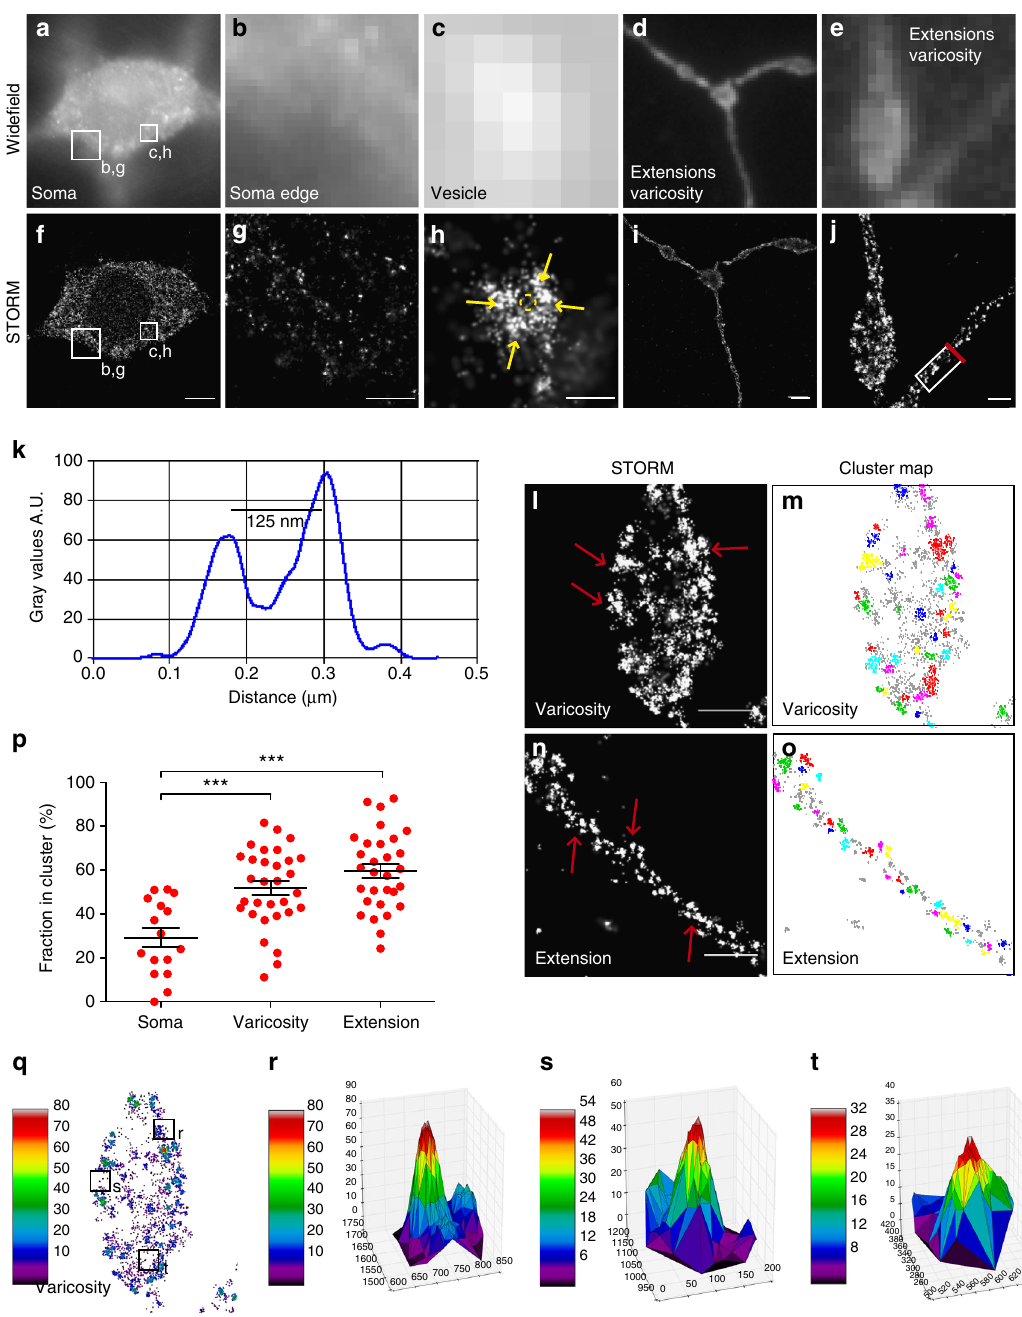
Fig. 3 Endogenous DAT is clustered in nanodomains in the extensions and varicosities of cultured dopaminergic neurons. a – c , f – h Cross-section views through dopaminergic cell body showing the DAT distribution in the soma in an overall view, the soma edge, and in intracellular vesicular structures. DAT was visualized by immunolabeling with primary DAT antibody and Alexa405-Alexa647-conjugated secondary antibody. a , f Wide fi eld image and corresponding reconstructed STORM image in the cell body. b , g Wide fi eld image and corresponding STORM image at the soma edge; c , h Enlarged wide fi eld or STORM image corresponding to the boxed regions in a , f , visualizing DAT in a putative endocytic vesicle. Yellow arrows highlight the circular distribution of the DAT signal. d , i Wide fi eld image and reconstructed STORM image in a representative extension with varicosities. e , j Enlarged wide fi eld image and corresponding STORM image of extension and varicosity. k Cross sectional pro fi le along the boxed region in j showing the signal intensity as a function of the distance ( µ m). l , m STORM image and corresponding DBSCAN-based cluster map showing the degree of clustering of DAT in a representative varicosity. n , o STORM image and corresponding DBSCAN-based cluster map showing the degree of clustering of DAT in a representative extension. Clustered localizations are shown by color-coding with non-clustered localizations in gray . p DBSCAN-based quanti fi cation of the clustering of endogenous DAT in dopaminergic neurons in soma, varicosities and extensions. Data are % of localizations in cluster (means ± s.e.m., *** p < 0.001, one-way ANOVA and Bonferroni ’ s post-test). Data are from 16 to 32 images from six individual experiments. Red arrows mark DAT clustered in nanodomains. q Varicosity from image n , where the localizations are colored by the number of nearest neighbors within a 30 nm radius. r – t Example clusters of varied densities identi fi ed in image q , where the number of nearest neighbors within a 30 nm radius are identi fi ed by color and by position on the z axis. Scale bars a , f , l 5 μ m, b , d , g , i 1 μ m, c , h , m 200 nm, e , j , n – q , s 500